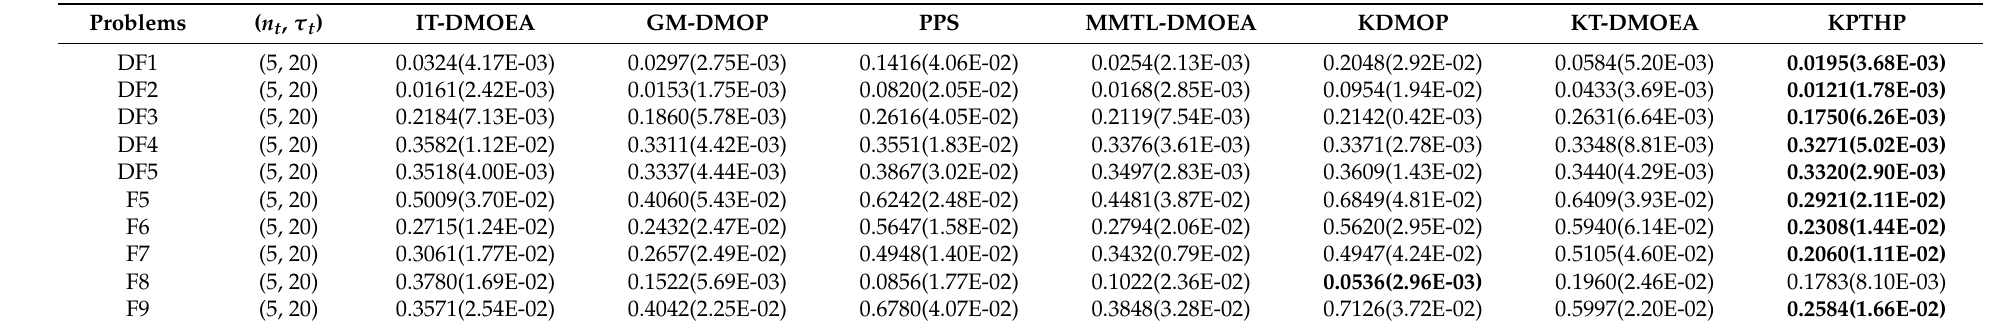
Table 3. Mean and SD of HVD indicator obtained by seven algorithms for ( n t , τ t ) = (5,